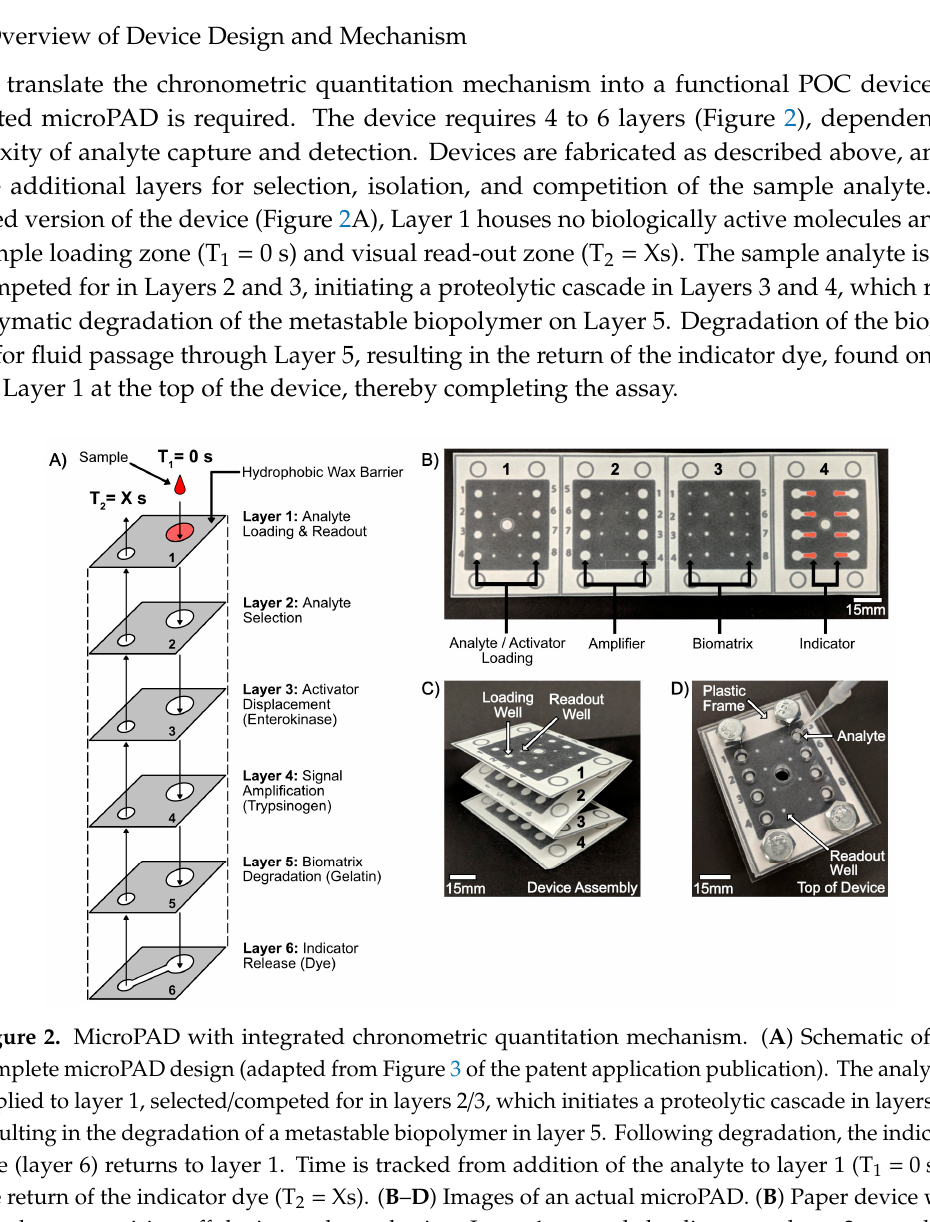
(zymogen), layer 3—metastable biomatrix (degradable biopolymer), and layer 4—indicator